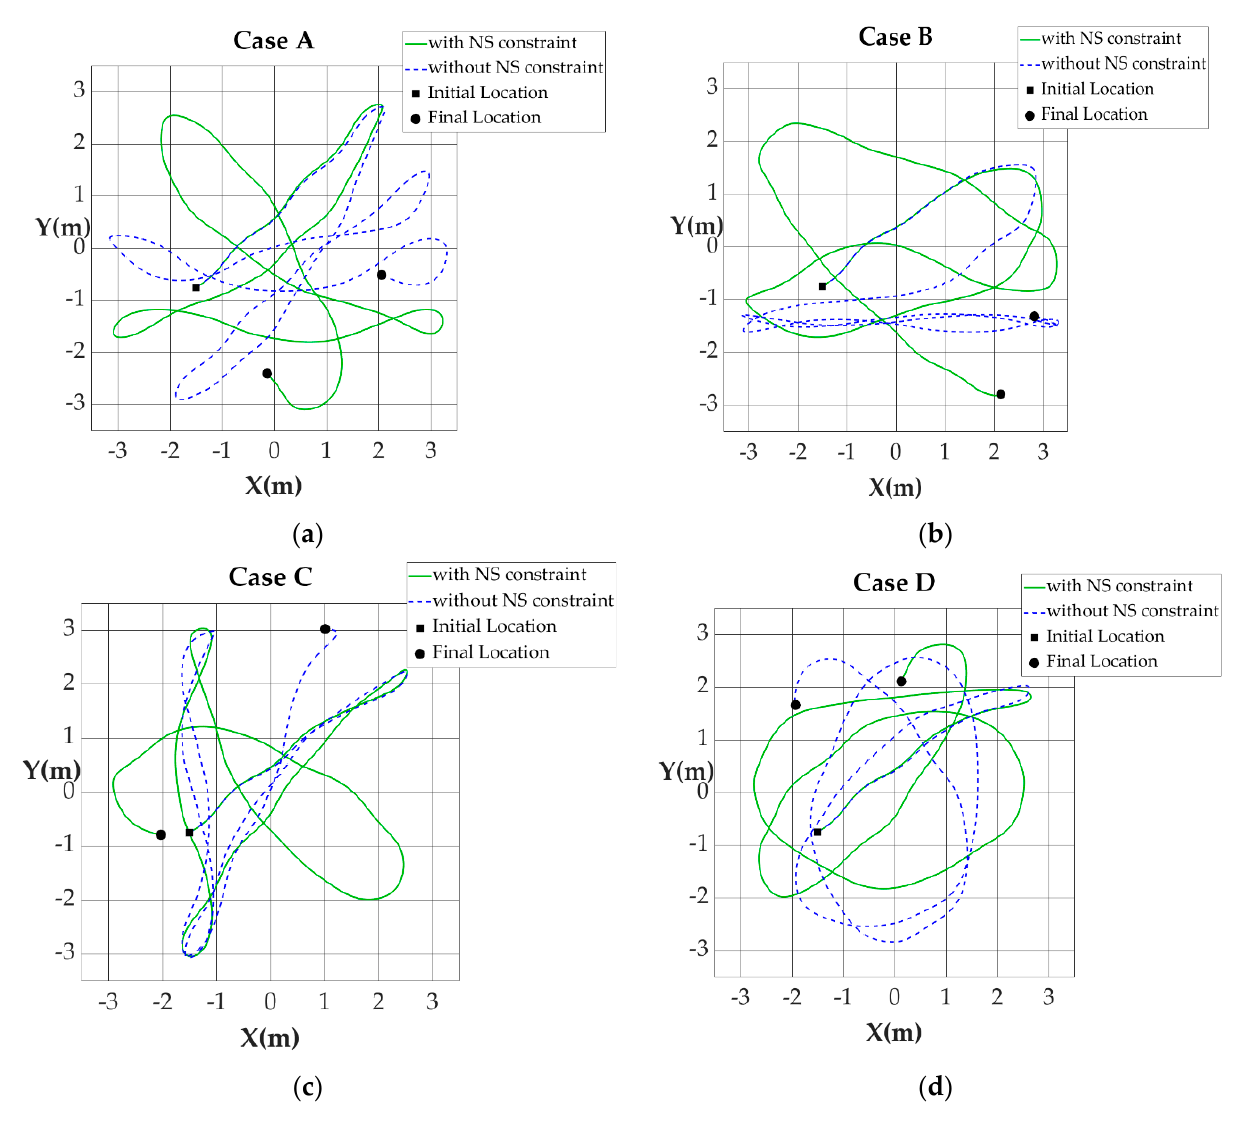
Figure 11. Comparison of the path taken by the point of contact P projected on the XY plane. The solid (green) line shows the trajectory with the No-Spin (NS) constraint and the dashed (blue) line without the No-Spin (NS) constraint for ( a ) Case A, ( b ) Case B, ( c ) Case C, ( d ) Case D.